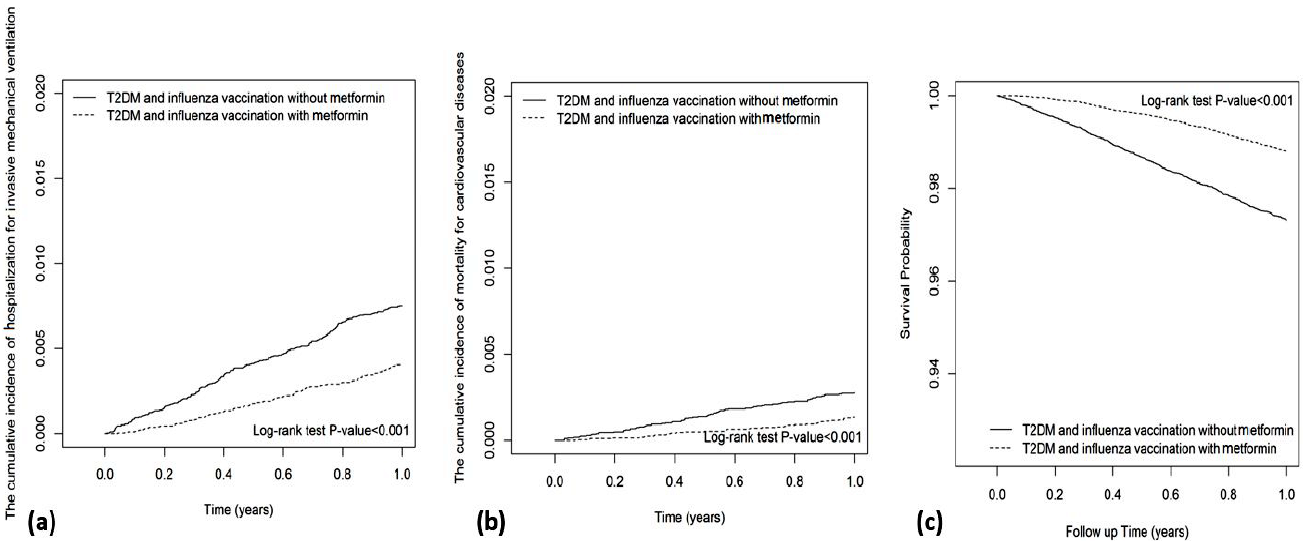
Figure 3. Cumulative incidences of ( a ) invasive mechanical ventilation, ( b ) death due to cardiovascular disease, ( c ) mortality.